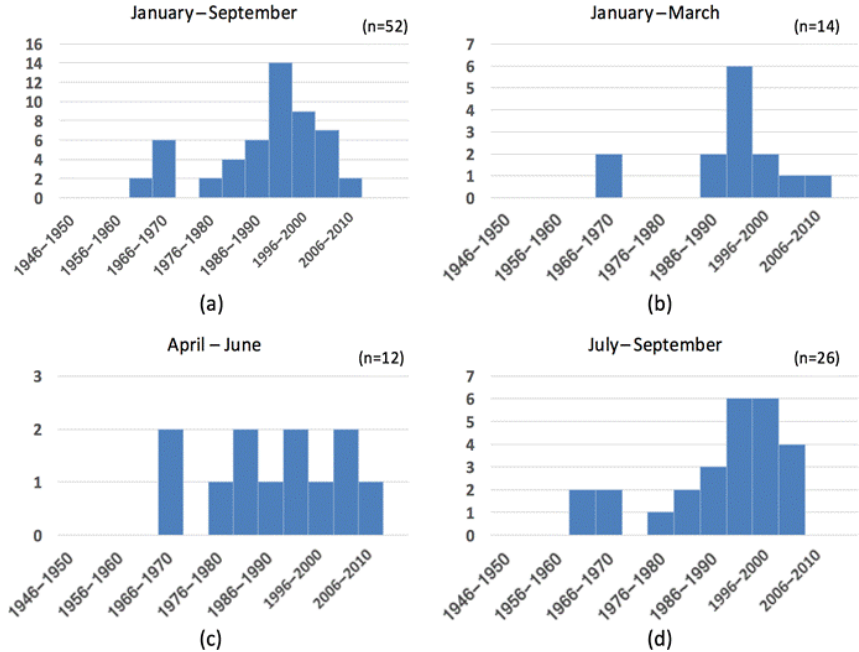
Figure 6. The distribution of break-point years across all regions for (a) January–September and its three subperiods: (b) January–March, (c) April–June, and (d) July–September. Only cases for which detrending using two lines, rather than one, reduced the rms error by 5% or more are included. Note that y axes have different scales.